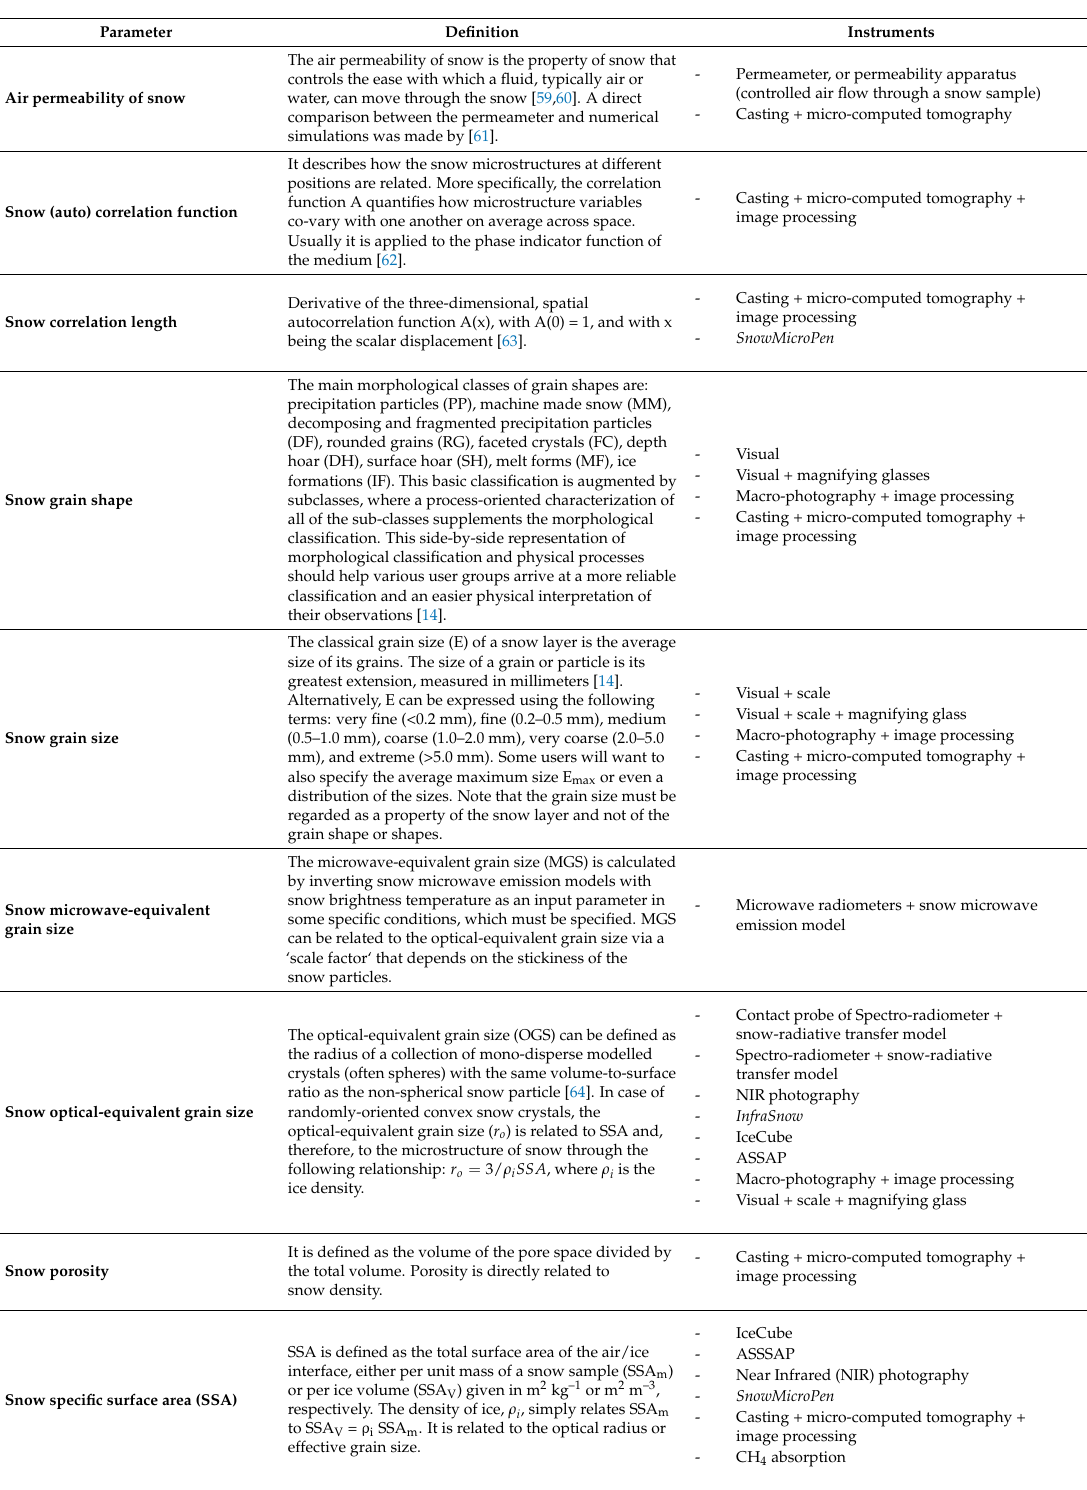
Table A2. List of measurable snow microphysical properties: name of the properties (first column), definition (second column), and existing